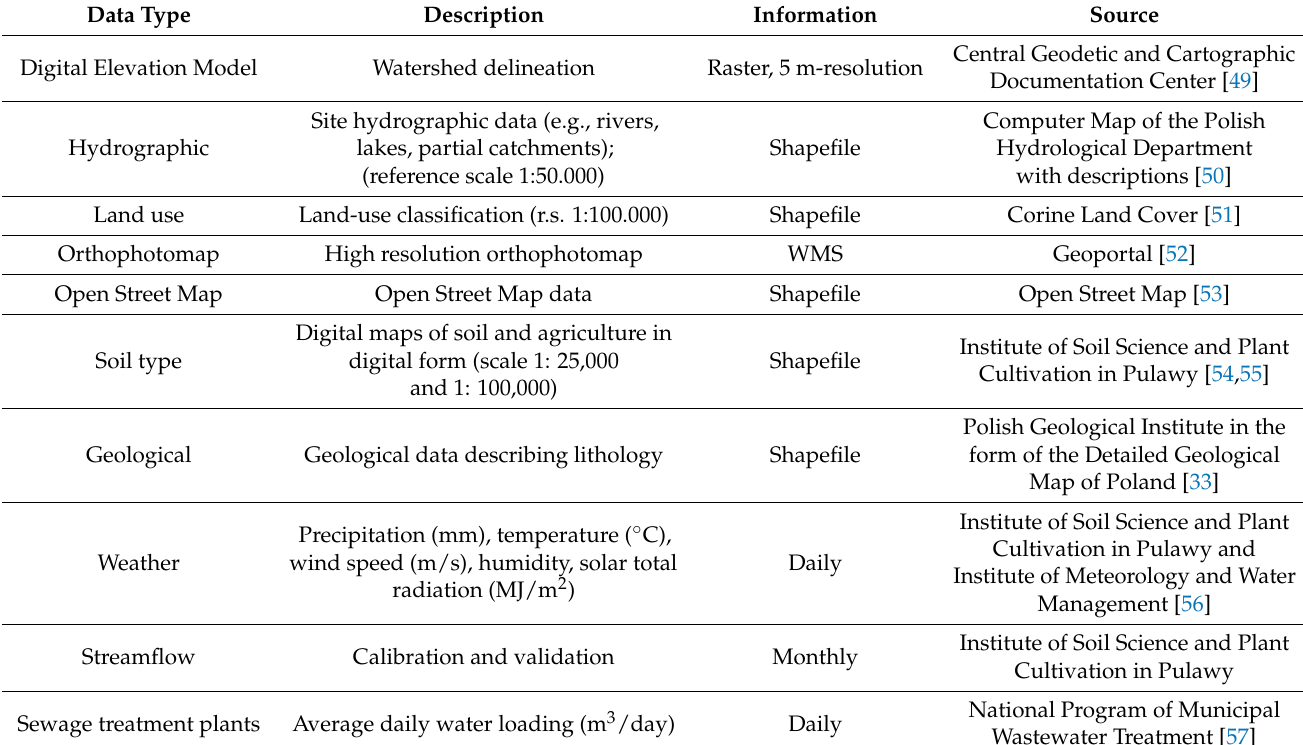
Table 1. Input data used in SWAT model (own